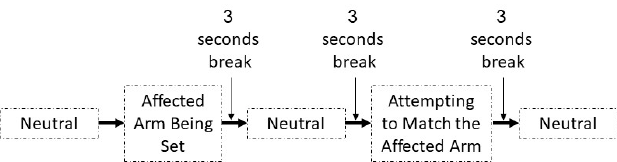
Figure 2. Study timeline.